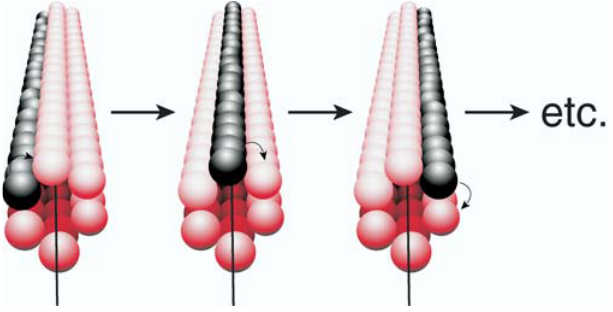
Figure 10. Coordination of ATP Hydrolytic Waves in a RecA Filament The dark monomers are those in the hydrolytic step of their hydrolytic cycle. The successive steps are separated by 0.5 s. The model shown assumes exactly six RecA monomers per helical filament turn and i = 6.0. As noted in the text, both the helical organization in the filament and the organization of ATP hydrolytic waves in RecA filaments may deviate slightly from this ideal. Note that there is no evidence that a RecA monomer in a filament is in contact with another RecA located six monomers away, so each of the gray balls shown in these illustrations are separated from their gray neighbors. An animated version of this model is available in Video S1. DOI: